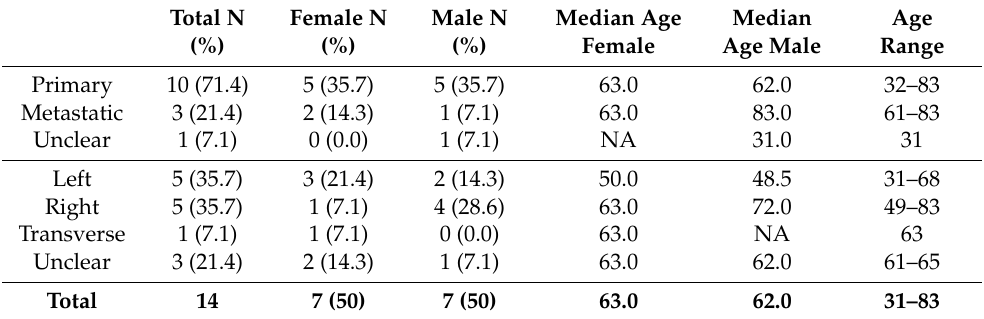
Table 1. Demographics and cohort specifics listed by sex and tumor location used for genomic assessment (primary vs. metastatic tumor) or sidedness of the primary tumor ( p = 0.59 for median age of males vs. females).